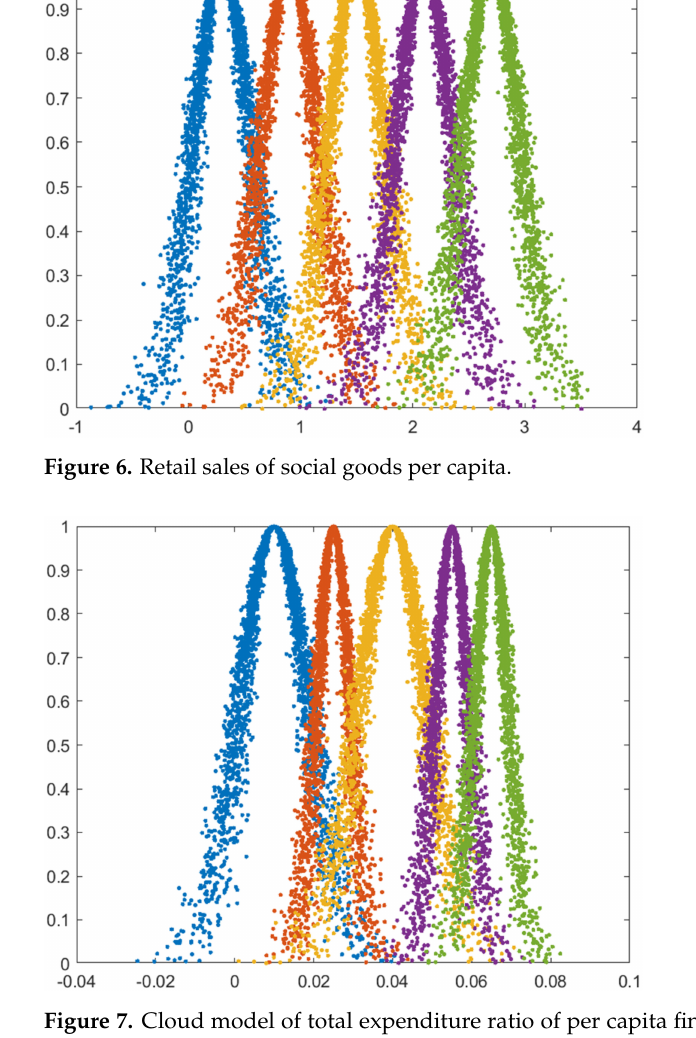
Figure 7. Cloud model of total expenditure ratio of per capita financial environmental protection